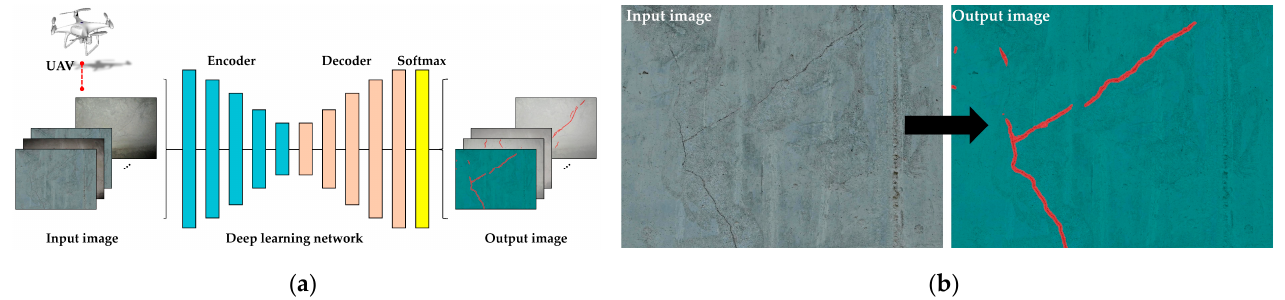
Figure 5. Deep learning-based automated damage detection: ( a ) network architecture; ( b ) automated damage detection result.